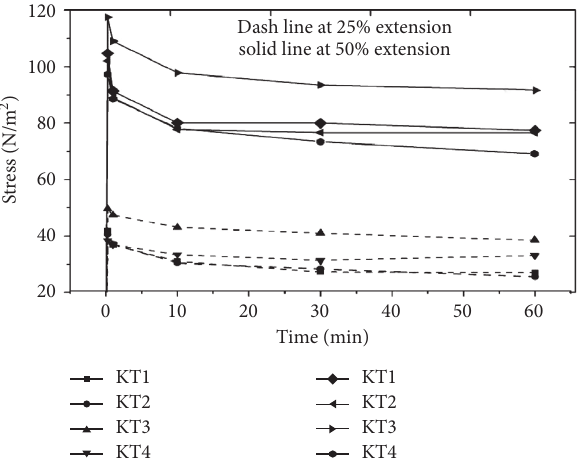
Figure 8: Stress response of the therapeutic tape under two levels of extension. Table 5: Elongation after number of cycles in the warp direction.